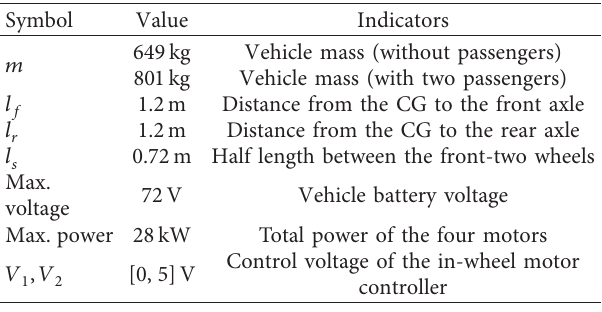
Figure 2: The FWID EV configuration. Table 1: Vehicle parameters.